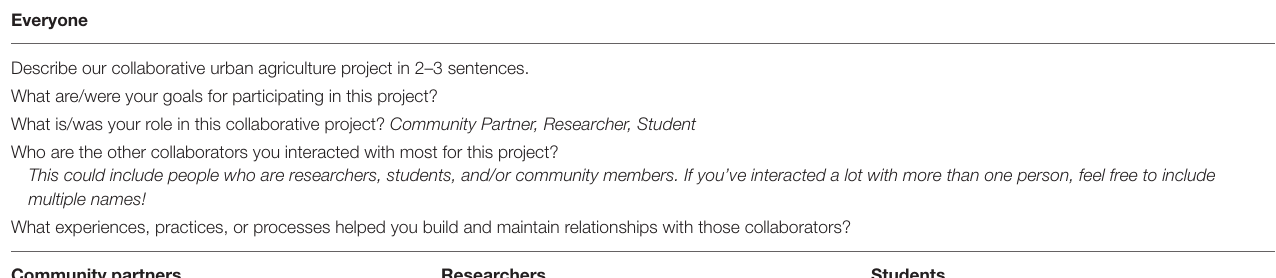
TABLE 1 | Evaluation Survey Questions.